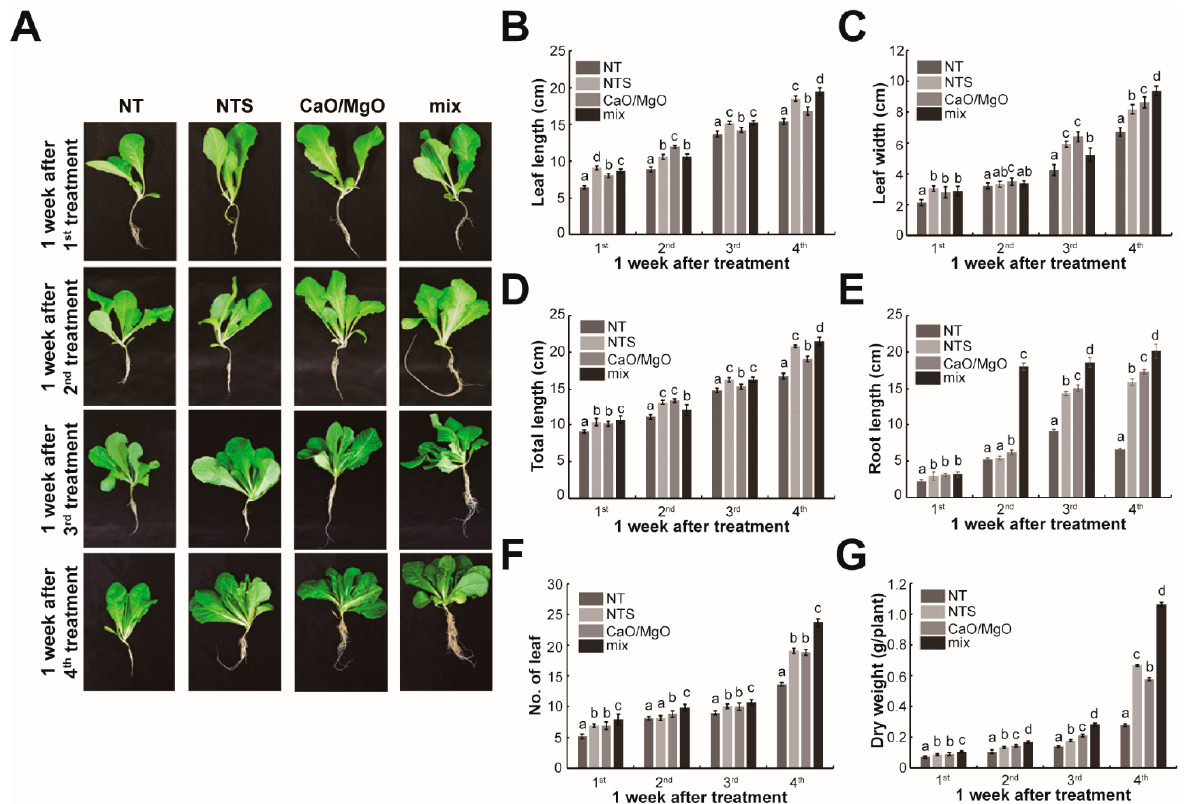
Figure 1. Effect of NTS, CaO/MgO, and mixed treatment on the morphological and physiological changes of leaf lettuce. Representative image showing phenotype changed during NTS ( A ), CaO/MgO, and mixed treatment. Physiological changes were measured by leaf length ( B ), leaf width ( C ), root length ( D ), total length ( E ), leaf number ( F ), and dry weight ( G ). NT, nontreatment group; NTS, NTS treatment group; CaO/MgO, CaO/MgO treatment group; mix, mixed (NTS, CaO, and MgO) treatment group. All experiments were repeated three times, and the error bars indicate standard deviation ( n = 12). Different letters above bars indicate statistically significant differences as determined by one-way ANOVA ( p < 0.05).